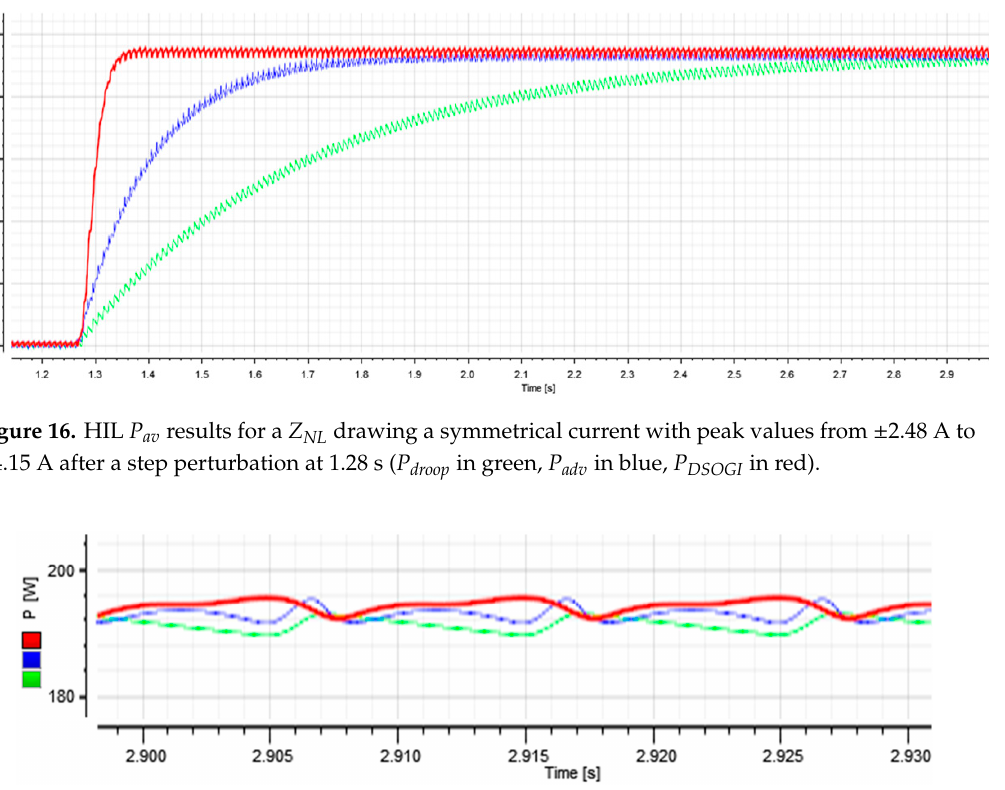
Figure 17. Detail of HIL P av ripples at steady-state from Figure 14 ( P droop in green, P adv in blue, P DSOGI in red).